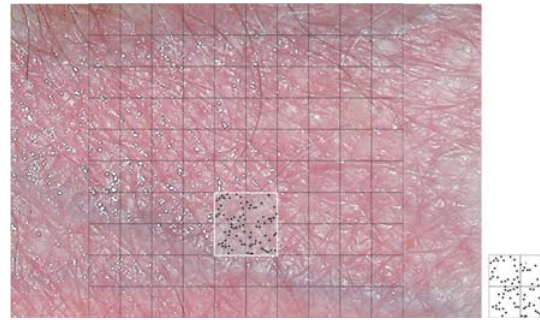
Figure 3 - Image of sweat drops emerging from skin taken by a Nikon digital photo camera and processed using the Image Tools